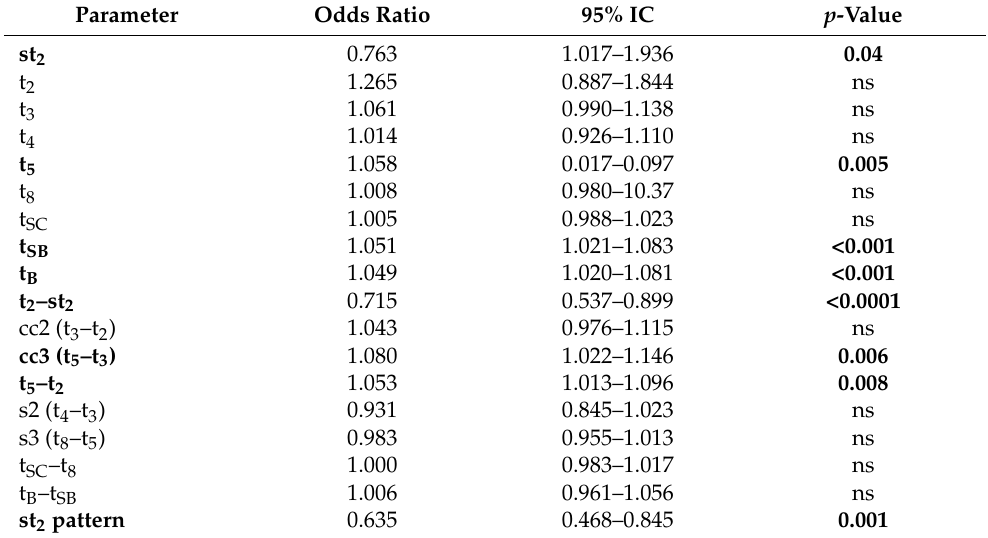
Table 3. Univariate logistic regression analysis.